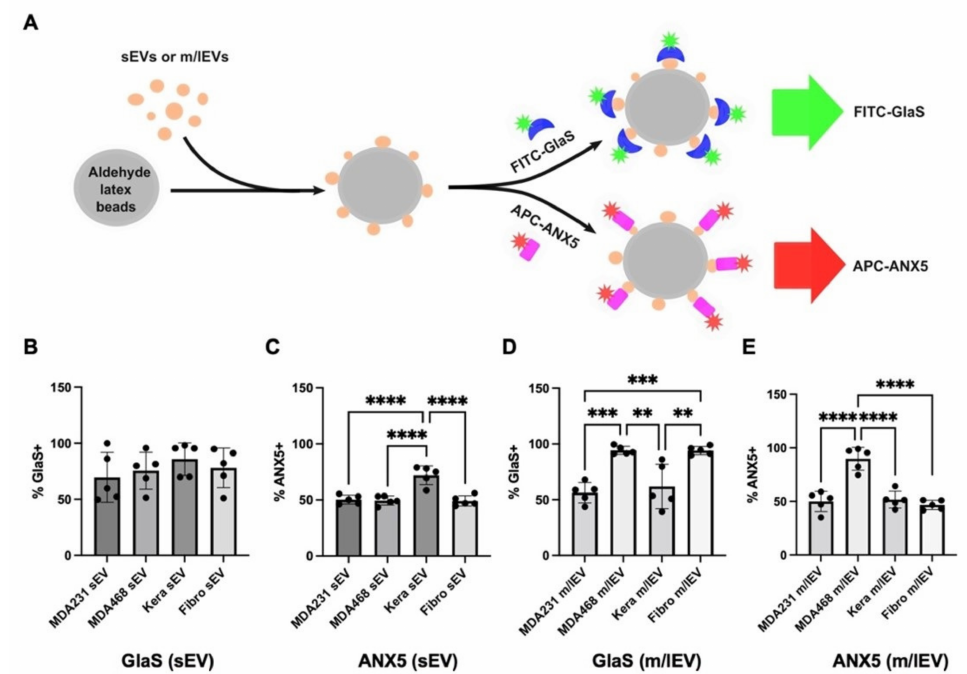
Figure 3. Bead-based analysis of phosphatidylserine (PS)-exposing sEVs and m/lEVs. ( A ) A schematic diagram of EV capturing on beads and analysis of their PS exposure by fluorescein isothiocyanate (FITC)-GlaS and allophycocyanin (APC)-annexin A5 (ANX5) proteins. ( B – E ) The beads capturing small EVs (sEVs) or medium/large EVs (m/lEVs) were labeled with FITC-GlaS or APC-ANX5 and analyzed by flow cytometry. The graphs show % of the FITC or APC positive EV-coated beads. Error bars, the standard deviation of five independent analyses, ** p < 0.01; *** p < 0.001; **** p <